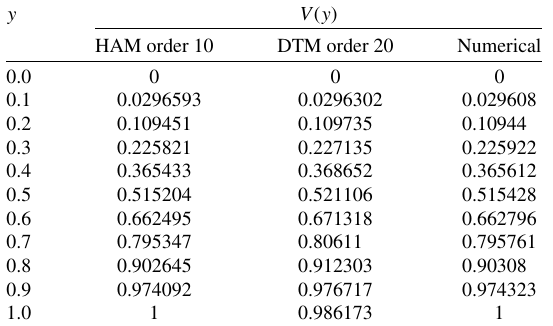
Fig. 19. Variation of entropy generation parameter, N G ( y ) , with respect to y for different values of dimensionless horizontal coordinate. Table 2 Comparison of values of V ( y ) obtained by various orders of the HAM with numerical solution, when Re = 1 . 0 and Ha = 1 . 0